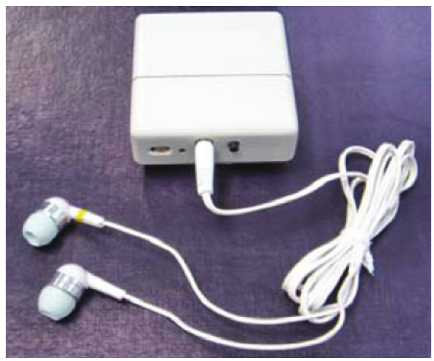
Figure 1: PDN-01B digital hearing aid